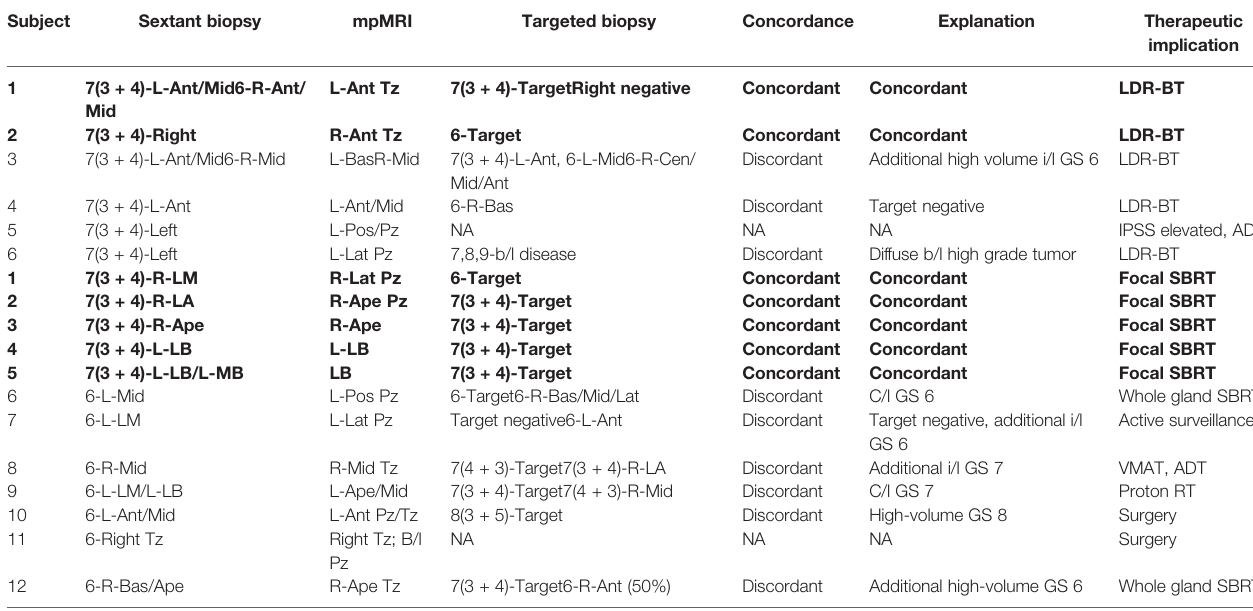
TABLE 2 | Pathology and mpMRI